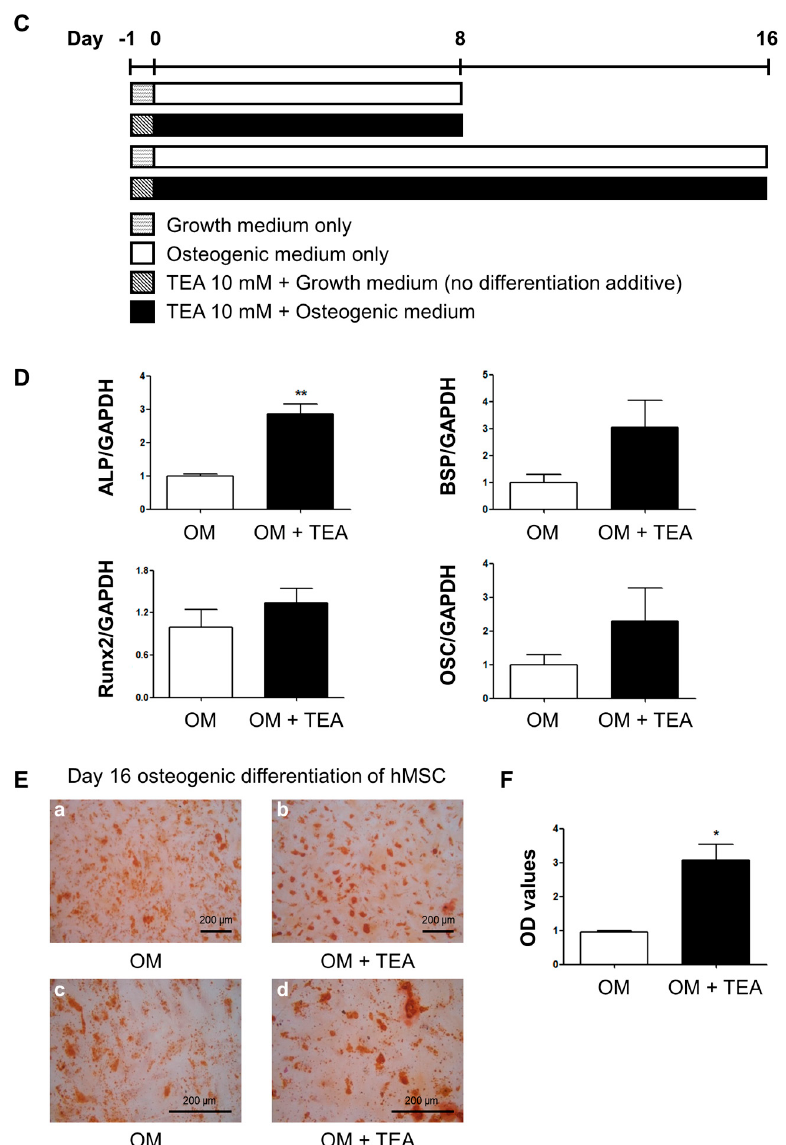
Figure 1. Regulation of human mesenchymal stem cell (hMSC) osteogenic differentiation by tetraethylammonium (TEA). Matrix mineralization was evaluated via Alizarin Red S staining. ( A ) Differentiated hMSCs in osteogenic-induction medium (OM) produced calcium deposits and were dyed red (right), while the cells cultured in growth medium (GM) were not stained (left). The hMSCs were differentiated for 10 days; ( B ) The OD values for Alizarin Red S staining showed that hMSCs cultured in OM had a greater calcium content than those in GM; ( C ) Scheme for the protocol of TEA treatment during hMSC osteogenic differentiation. Cells were pre-incubated with 10 mM TEA for 1 day without any differentiation additives. OM containing TEA was used to induce hMSC osteogenic differentiation; ( D ) The mRNA expressions of osteogenic differentiation markers were analyzed with qRT-PCR at day 8 of osteogenic differentiation. The mRNA expression of ALP was significantly increased. The expressions of BSP and OSC tended to increase, although not statistically significantly. There was no significant change in Runx2 expression; ( E ) Alizarin Red S staining demonstrated that hMSC osteogenic differentiation was increased by TEA. The hMSCs treated with TEA produced greater calcium contents; ( F ) The OD values demonstrated that TEA increased hMSC osteogenic differentiation. The OD values were normalized with the Alamar Blue Assay to consider remained cell numbers ( n = 3). The data are presented as mean ± SEM. * p < 0.05; ** p < 0.01; and *** p < 0.005 compared to controls. Scale bar represents 200 μ m. ALP: alkaline phosphatase; BSP: bone sialoprotein; OSC: osteocalcin; OD: optical density.